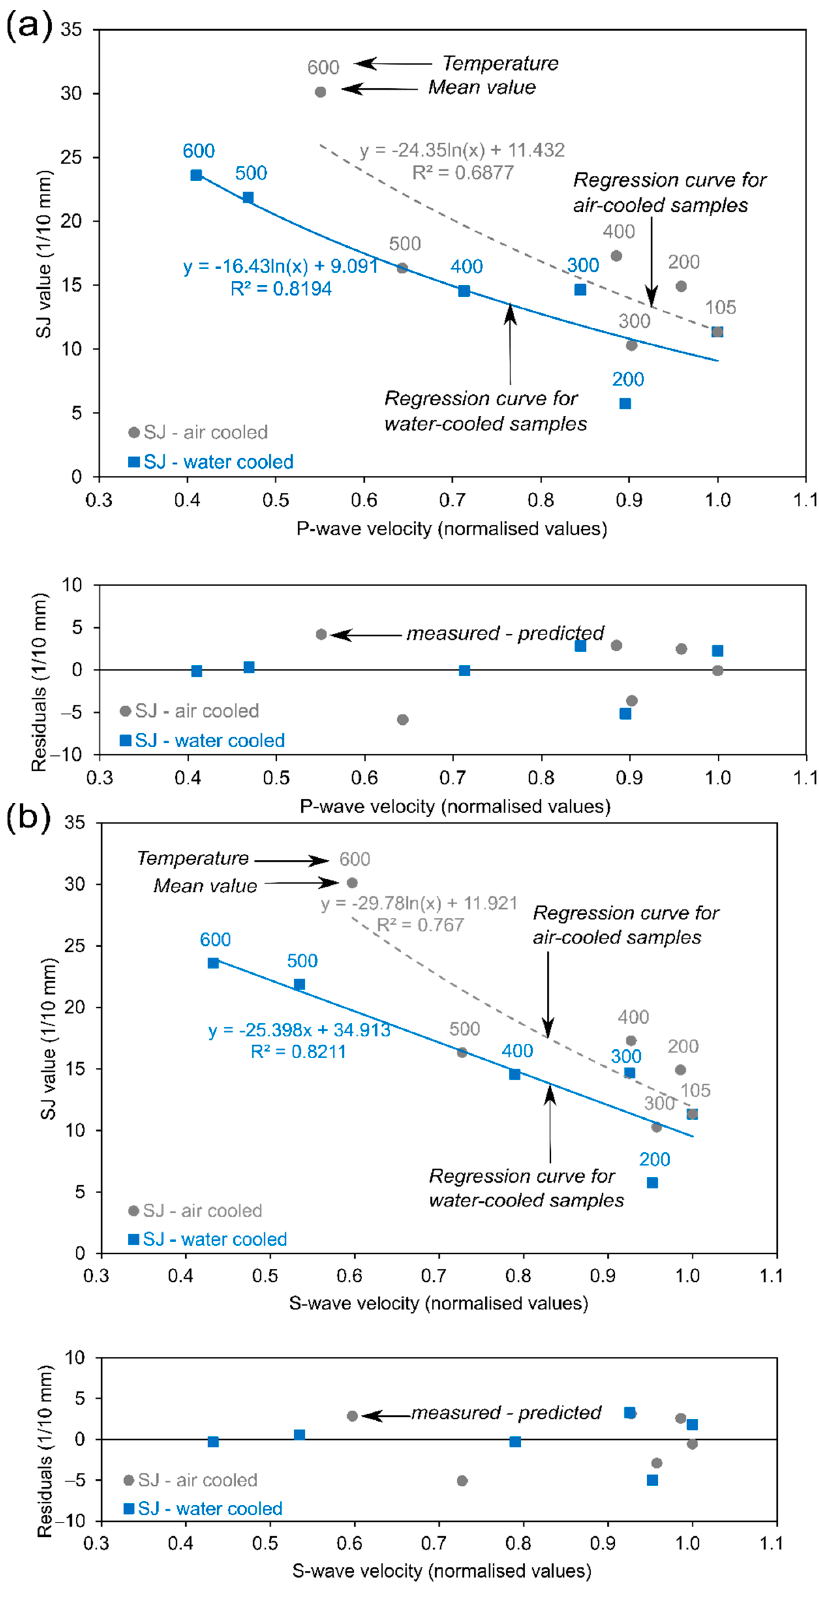
Figure 12. Correlations between variation of SJ and ( a ) P- wave velocity; and ( b ) S-wave velocity for air- and water-cooled